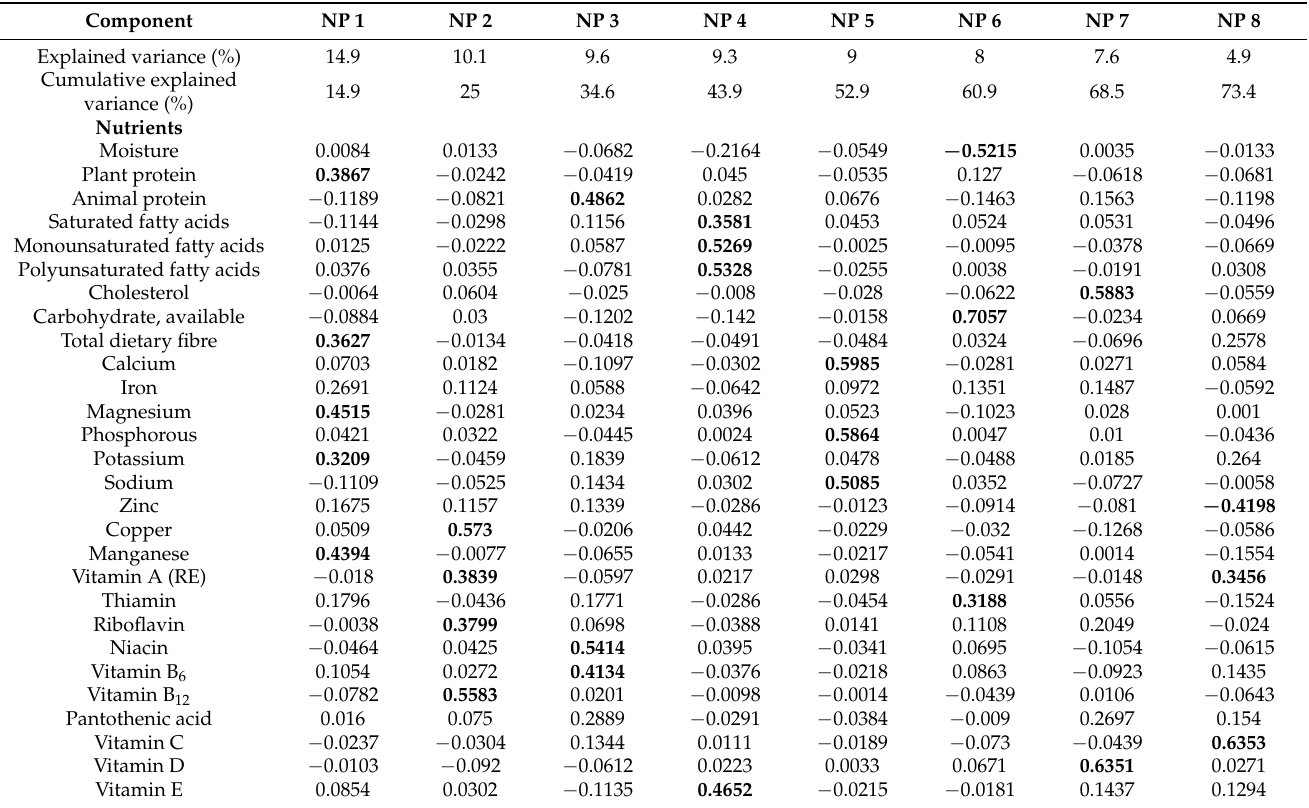
Table A1. Explained variance and rotated principal component loadings for the first eight nutrient patterns (NPs) identified by the analysis of nutrients.